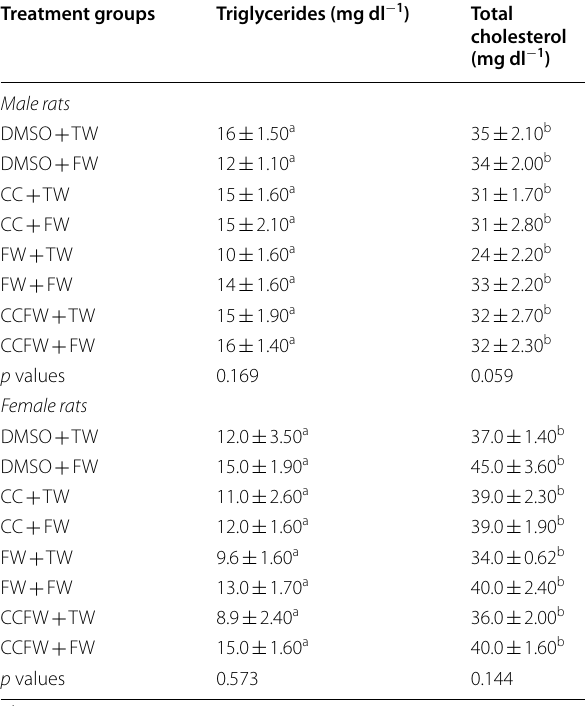
Table 4 High-fructose diet impact on lipid biomarkers at post- natal day 63 in male and female rats administered curcumin during suckling Treatment